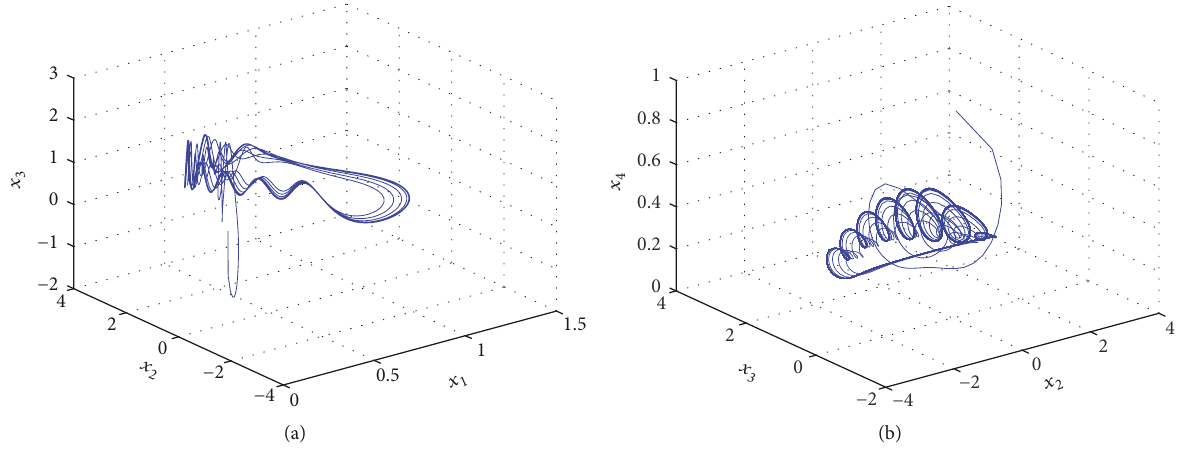
Figure 8: 3D phase portraits of the fractional order smart grid